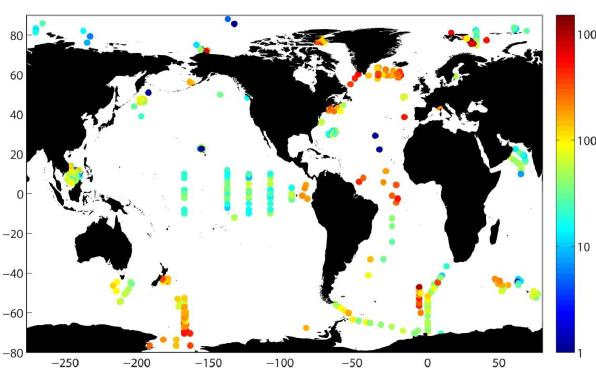
Figure 6. Mean POC export (mgm − 2 d − 1 ) in Longhurst provinces Fig. 6: Mean POC export (mg m -2 d -1 ) in Longhurst provinces (provinces with only one 265 (provinces with only one measurement are marked with a star). Ar- measurement are marked with a star). Areas in white represent areas where no data have been 266 eas in white represent areas where no data have been collected. Numbers on map indicate Longhurst province (cf. Table 2). collected. Numbers on map indicate Longhurst province (cf. Table 2). 267